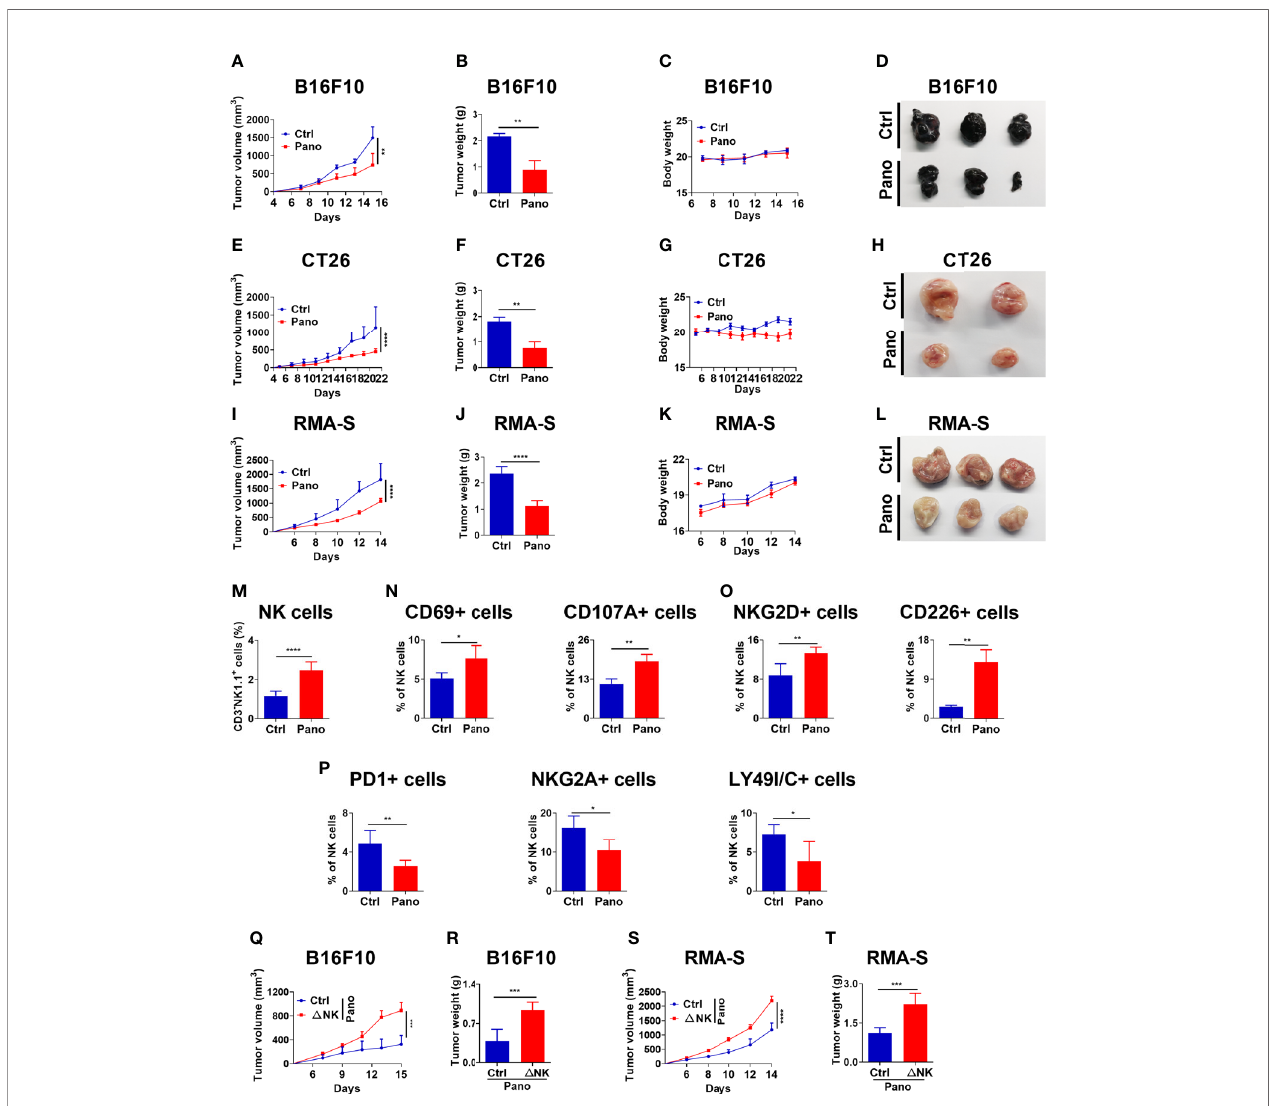
FIGURE 5 | HDACi (Panobinostat) therapy enhances better tumor control in vivo and promotes splenic NK cell activation. Evaluation of tumor growth kinetic upon Panobinostat therapy (Tumor growth curve, Tumor weight, Bodyweight and, Tumor images at the end of the experiment). Tumor growth kinetic followed with Panobinostat treatment for (A – D) C57BL/6 mice inoculated with B16F10 (2 X 10 5 cells/mice), (E – H) BALB/c mice inoculated with CT26 (2 X 10 5 cells/mice), (I – L) C57BL/6 mice inoculated with RMA-S (4 X 10 5 cells/mice). (M – P) Assessment of splenic NK cell activation, degranulation, and expression of selected surface receptors in an RMA-S tumor model. (M) percentage of splenic NK cells; (N) percentage of CD69+ and CD107A+ NK cells; (O) percentage of activating NK cell receptors; (P) percentage of inhibitory NK cell receptors. (Q – T) NK cell depletion ( D NK) one day prior to tumor inoculation, followed with Panobinostat therapy. Assessment of tumor growth kinetic (Q, R) B16F10 and (S, T) RMA-S, tumor models. (M – P) Data are expressed as mean ± SD (n= 6 replicates) from two independent experiments. Statistical signi fi cance was assessed by an t-test. (P > 0.05, *P ≤ 0.05, **P ≤ 0.01, ***P ≤